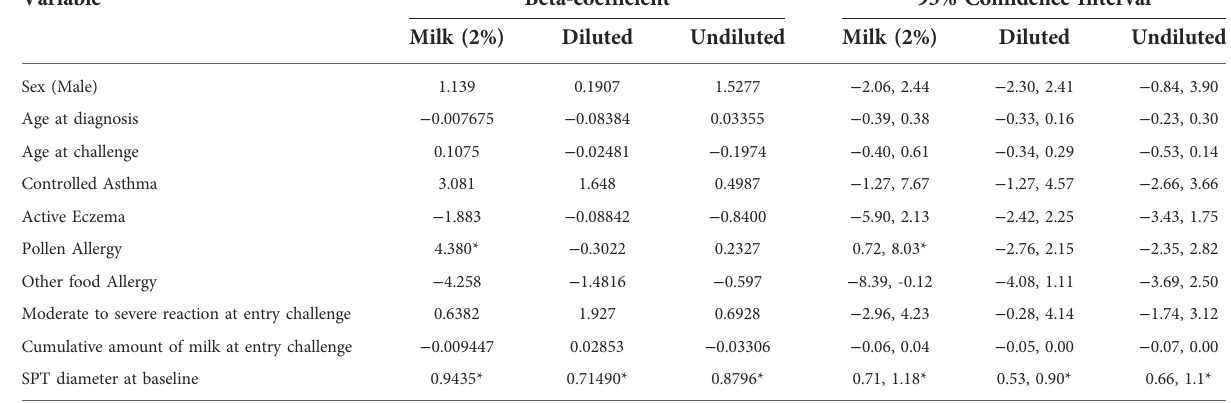
TABLE 3 Variables included in the linear